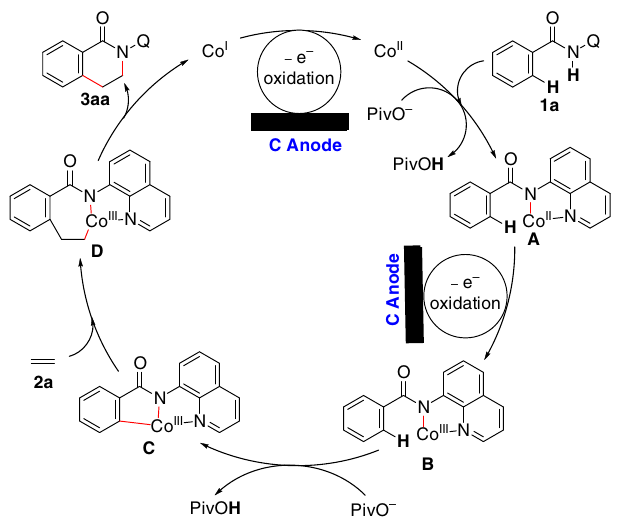
Fig. 7 Proposed mechanism for the reaction between 1a and 2a . Tentative reaction mechanism involves anodic oxidation of the coordinated Co(II) complex to generate a Co(III) complex, intramolecular C − H activation, ethylene insertion, and reductive elimination of Co(III) species to form the annulation product, and fi nally a second anodic oxidation to regenerate the Co(II)